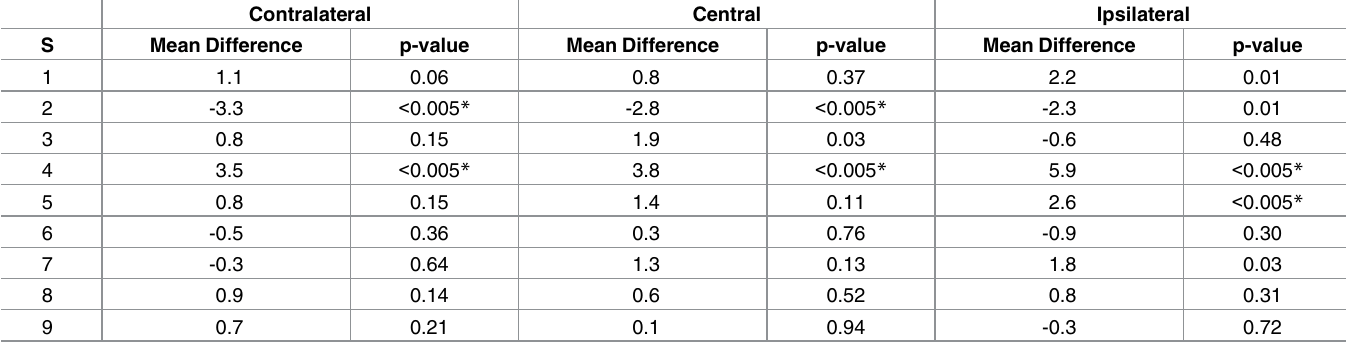
Table 3. Pairwise comparisons of signed errors between each subject and the control group in the 3 directions. Mean differences are evaluatedas Control-S. Significant differences are marked with an asterisk. Contralateral Central Ipsilateral S Mean